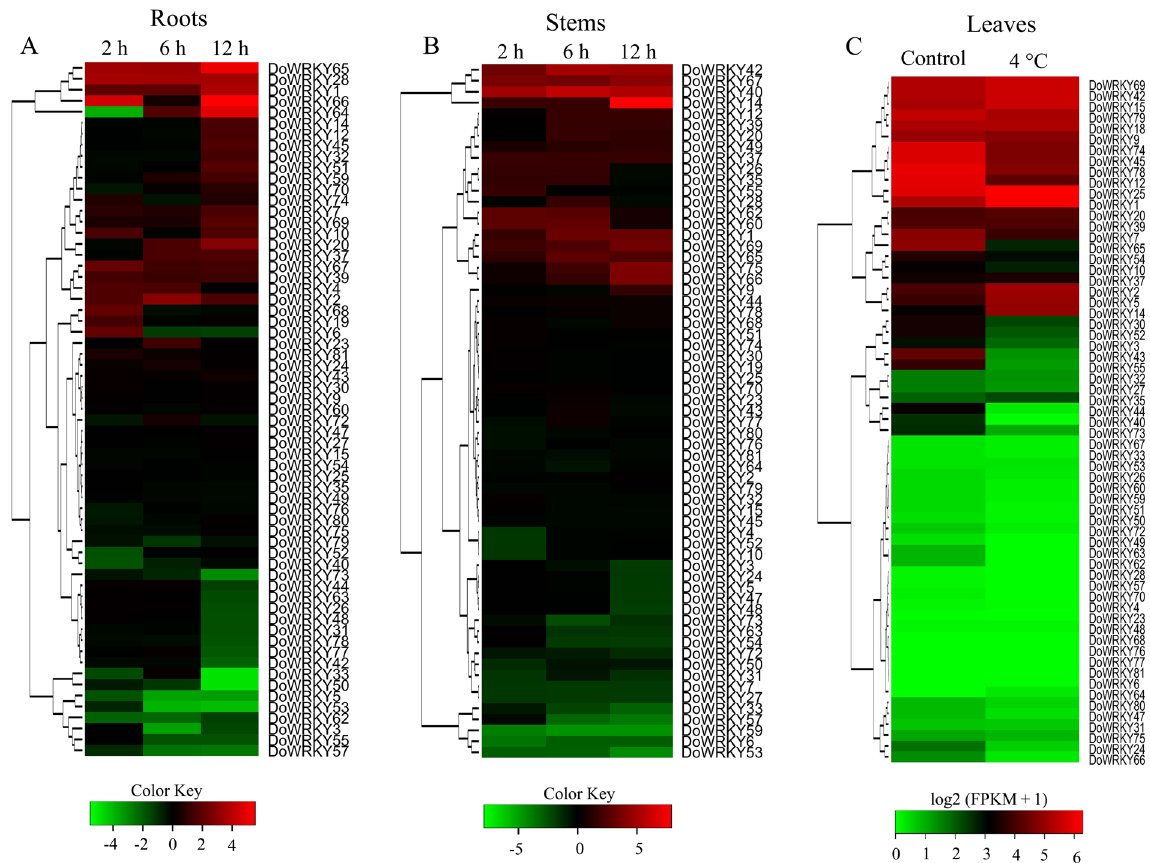
Figure 5. Expression profiles of DoWRKY genes with an expression pattern in roots, stems and leaves of Dendrobium officinale under cold (4 °C) stress. ( A and B ) Clustering of DoWRKY genes according to their expression profiles in roots and stems after cold treatments at four time points (0, 2, 6 and 12 h). The expression of the 63 DoWRKY genes was assessed based on an analysis of qPCR results. ( C ) Heat map showing expression pattern of DoWRKY genes in leaves under cold stress for 20 h. The Y-axis represents the value of the relative expression level [log 2 (mean of FPKM + 1)].